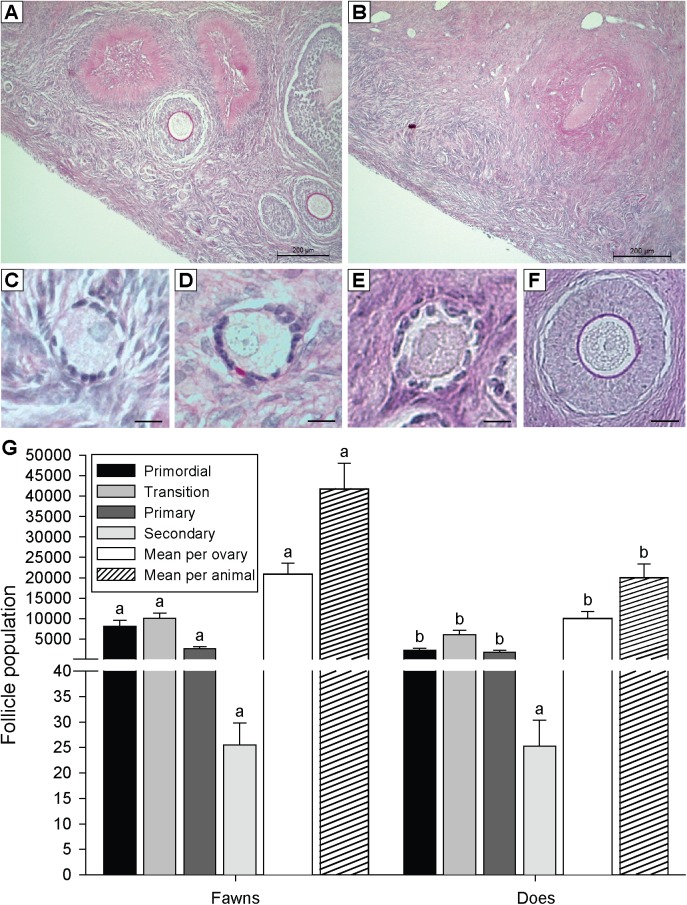
Characteristics of preantral follicle population in the ovary of white-tailed deer (A) fawns and (B) does, and preantral follicles classes such as (C) primordial, (D) transition, (E) primary, and (F) secondary. (G) Preantral follicle population according to follicle class for white-tailed deer fawns (n = 8) and does (n = 10).
a,b Within the same types of columns, values without a common superscript differed (P < 0.05). Bars = 10 μm (C–F).